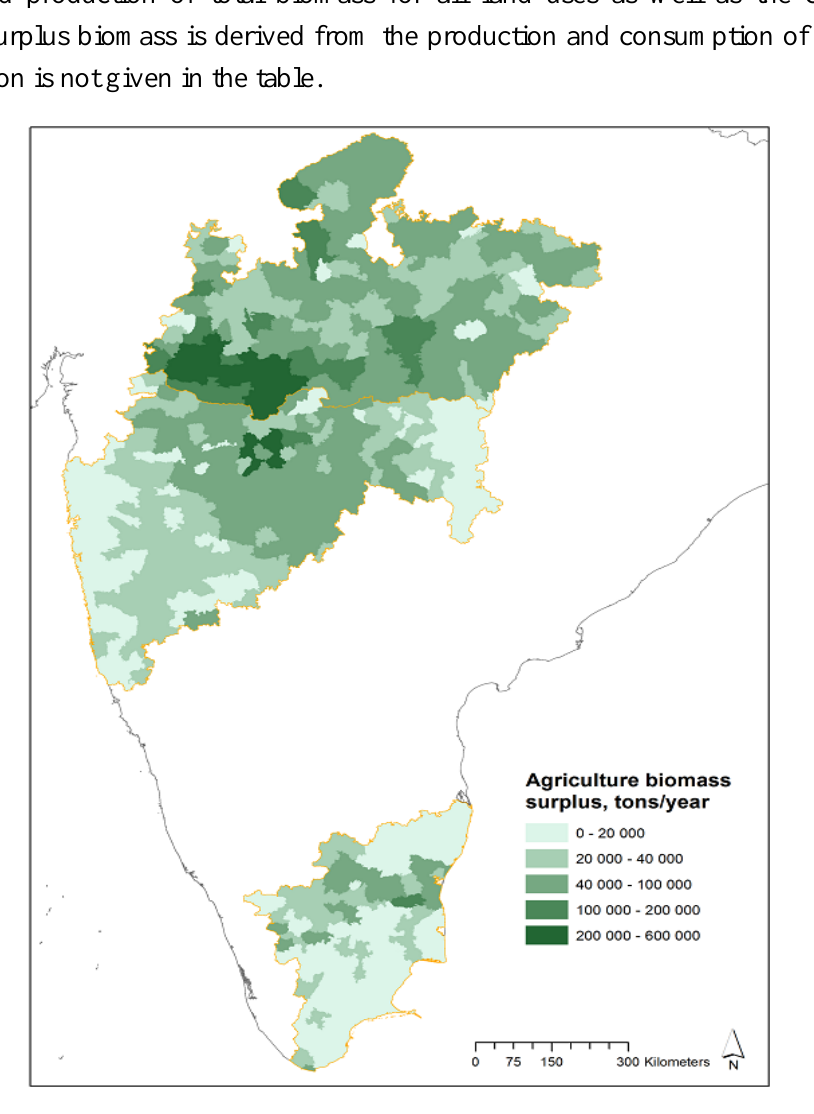
Figure 5. Surplus agro-biomass availability in MP, MH and